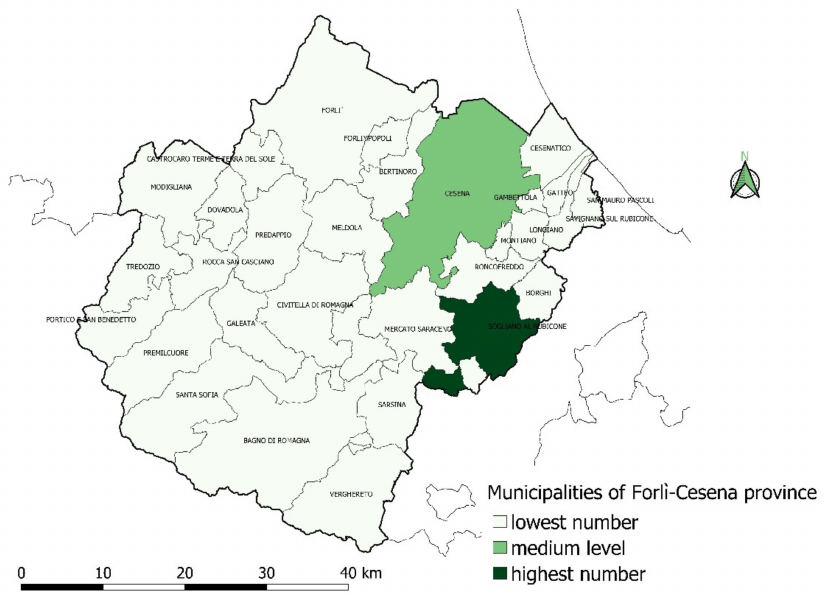
Figure 7. Forl ì -Cesena’s municipalities classification based on the number of plants that produce (WWTPs) and can potentially use (biogas plants) sewage sludge.